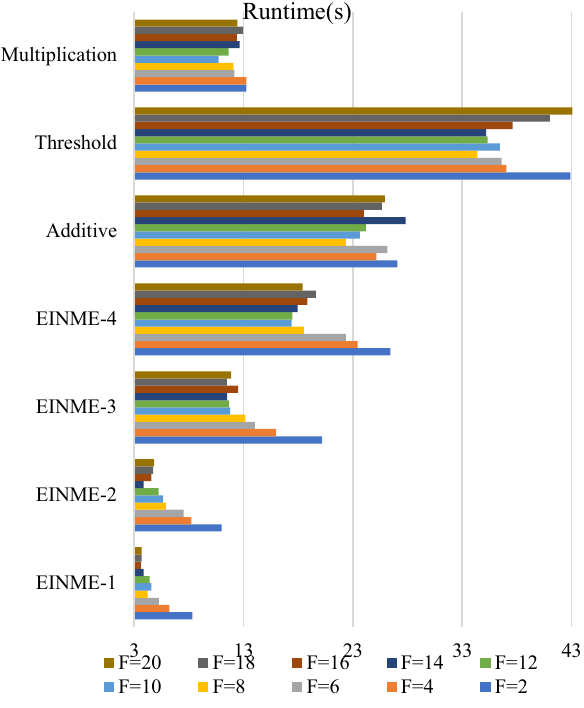
Fig. 7 Effect of parameter F on the runtime of